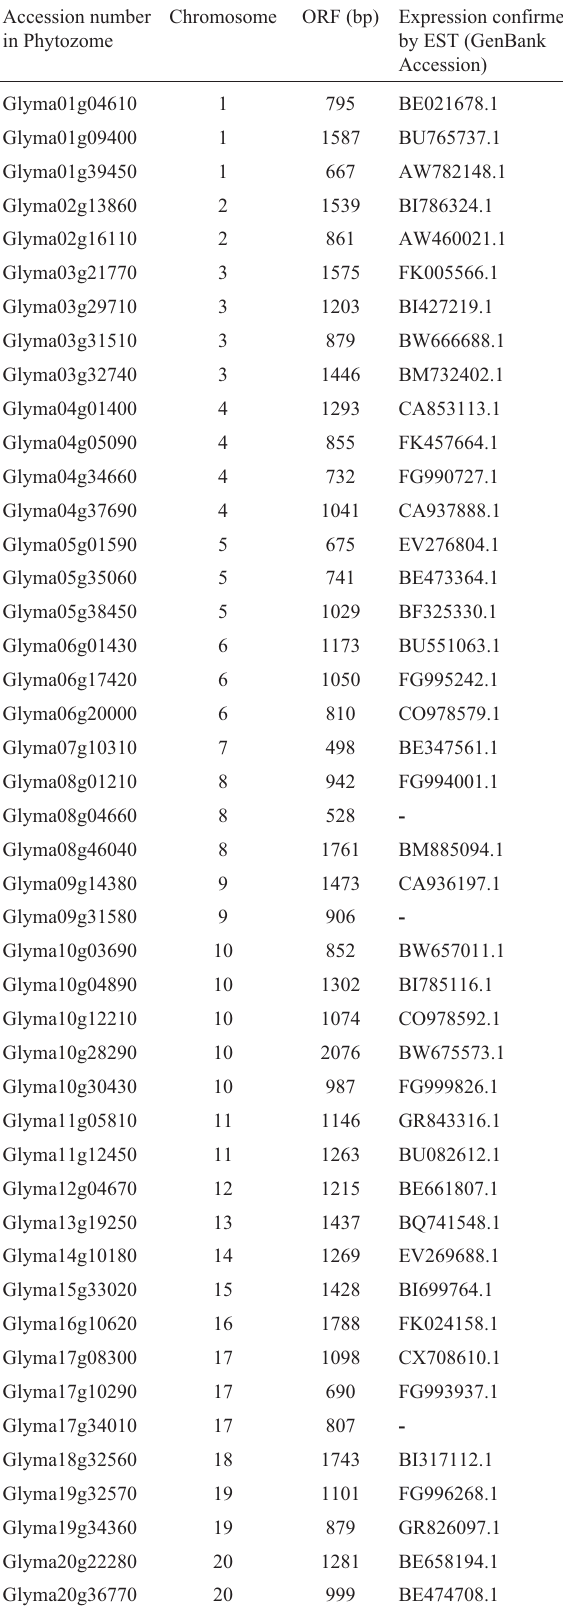
Table 1 - Annotation of soybean bHLH (subgroup 25)